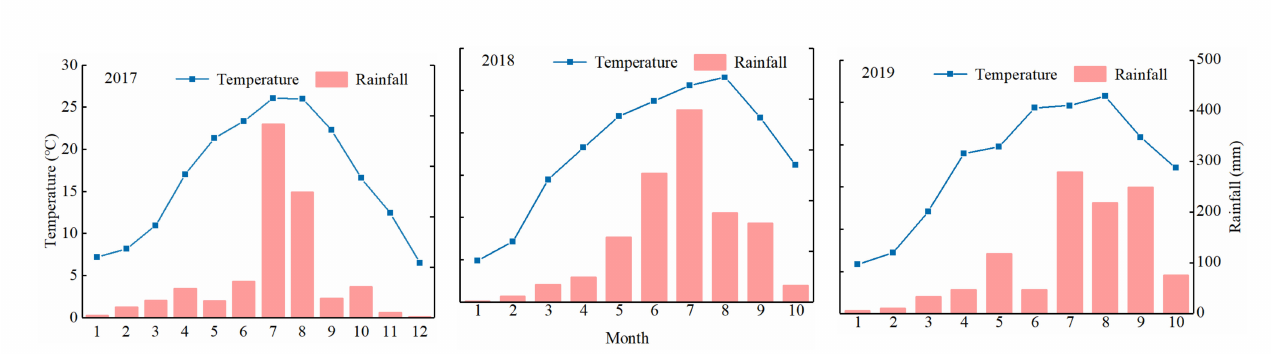
Figure 1. The meteorological data of the experimental area, including temperature and rain full in